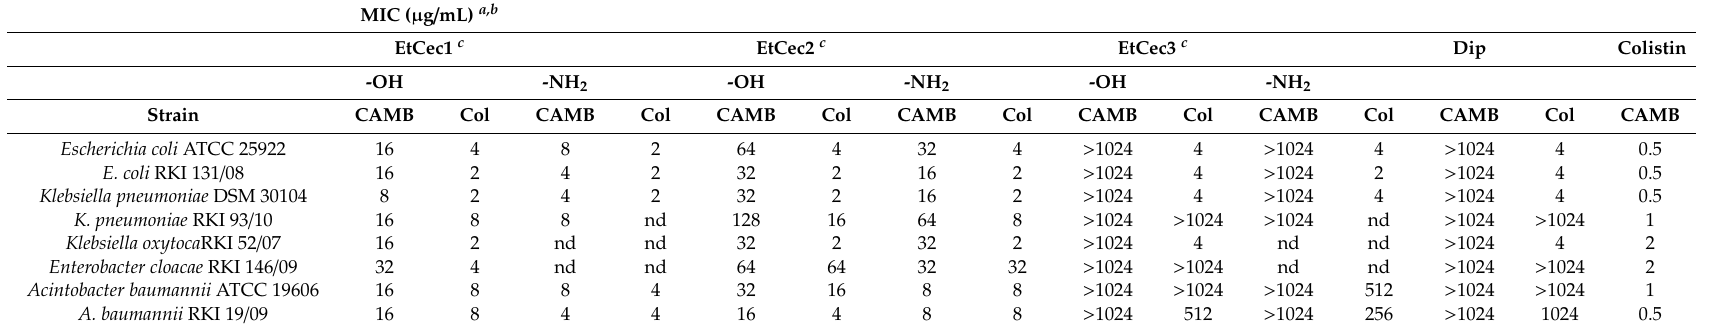
Table 5. Activity of Eristalis tenax peptides in the presence of sub-MIC concentrations of